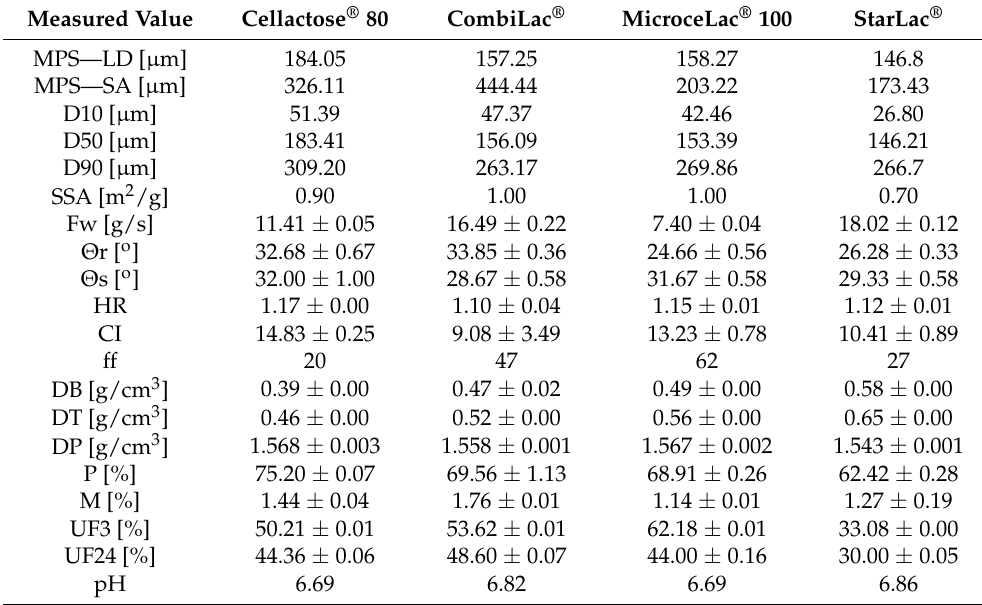
Table 2. Physical characteristics of CPEs.